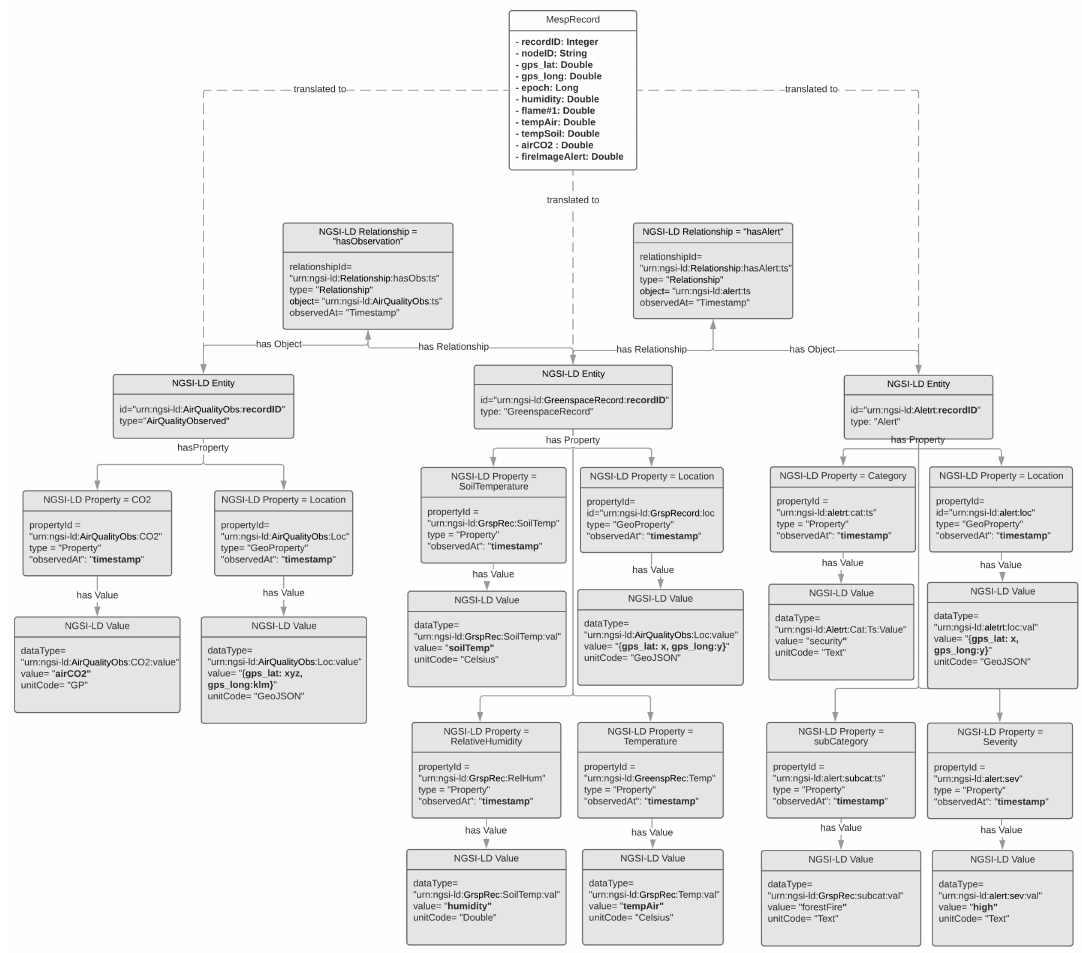
Figure 8. Data object model demonstrating the MESP record translation process to